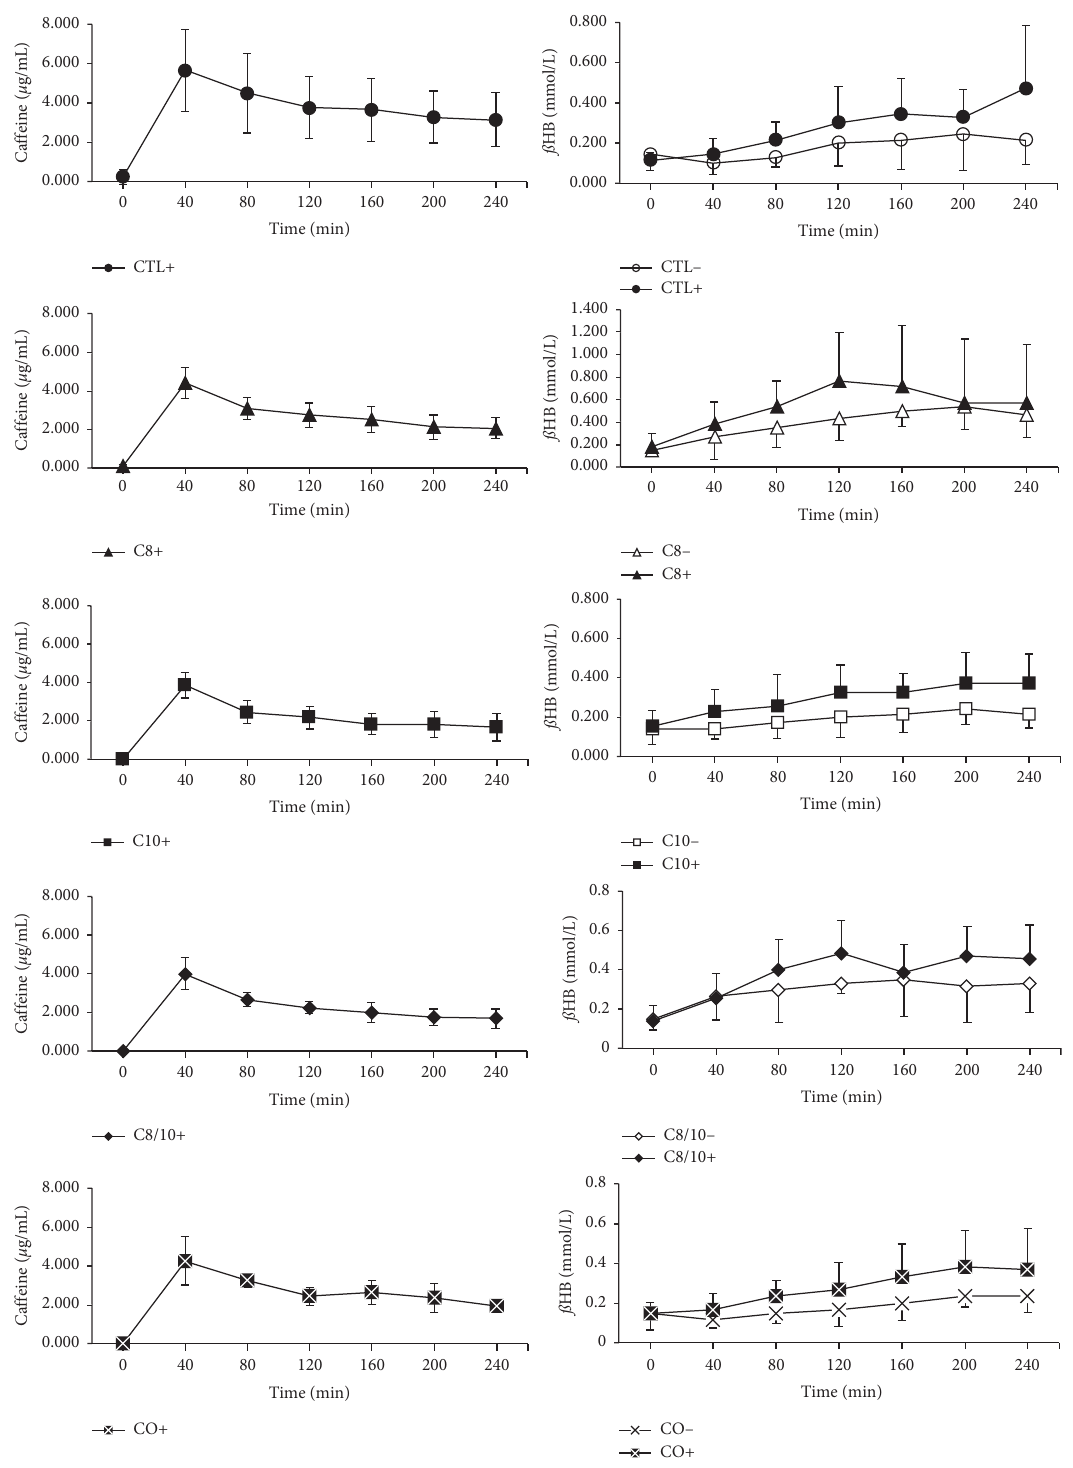
Figure 3: Overview of the curves (mean and standard deviation) of caffeine in saliva ( μ g/mL) from caffeinated interventions (CTL+, C8+, C10+, C8/10+, and CO+) and of ß HB (mmol/L) in capillary blood during all interventions over 240min ( t 0 – t 6 ). The interventions containing caffeine are in